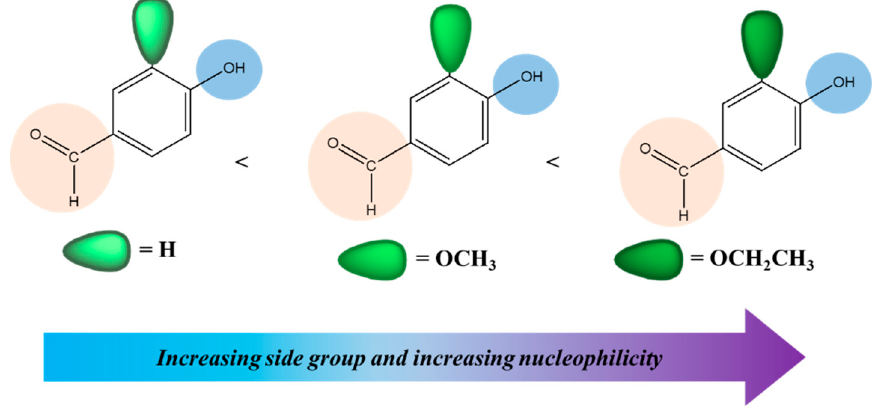
Figure 3. The simplified illustration of increasing side group and nucleophilicity affecting the rate of